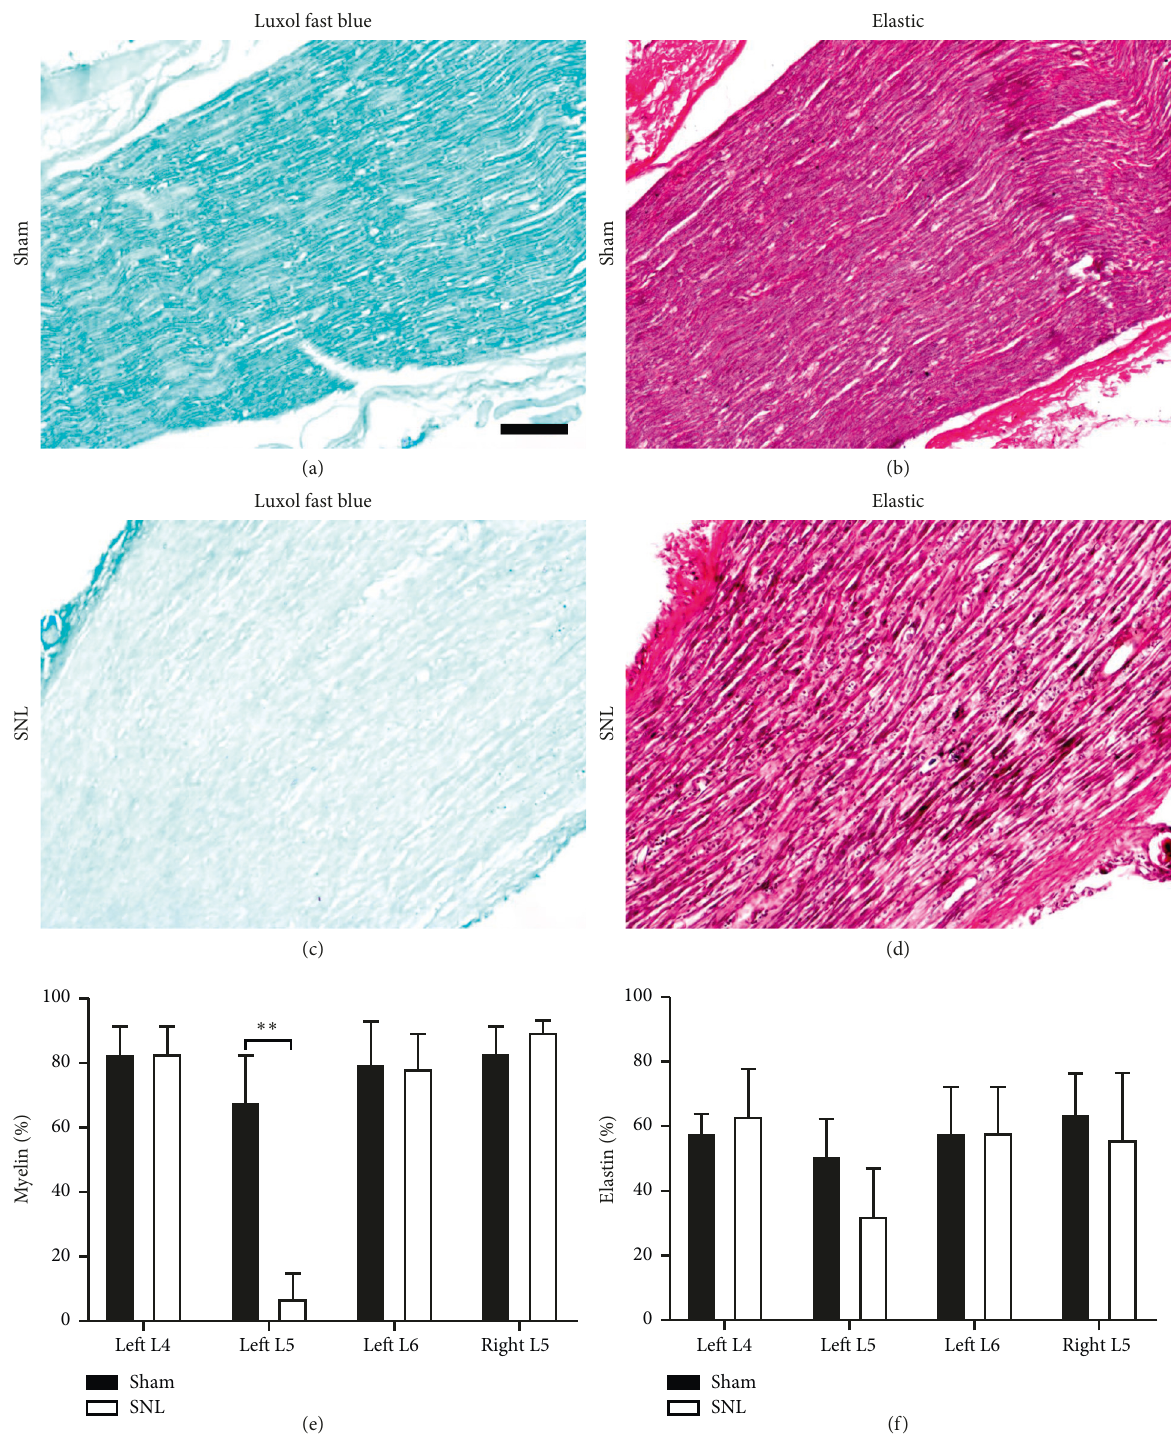
Figure 4: Demyelination and elastin fibre loss occurred at the site of ligation. (a–d) Representative images of Luxol Fast Blue (myelin: blue) and Verhoeff-van Gieson (elastin: black, nuclei: blue, and collagen: red) staining, on consecutive sections of the left L5 spinal nerve distal to the DRG, 1 week after SNL or sham surgery (scale bar � 100 μ m). (e) Myelin- and (f) elastin-positive areas of SNL and sham rats’ spinal nerves were quantified ( n � 5 per group). Statistically significant difference in the left L5 spinal nerve myelin content was determined by Mann–Whitney U test ( ∗∗ p < 0 .